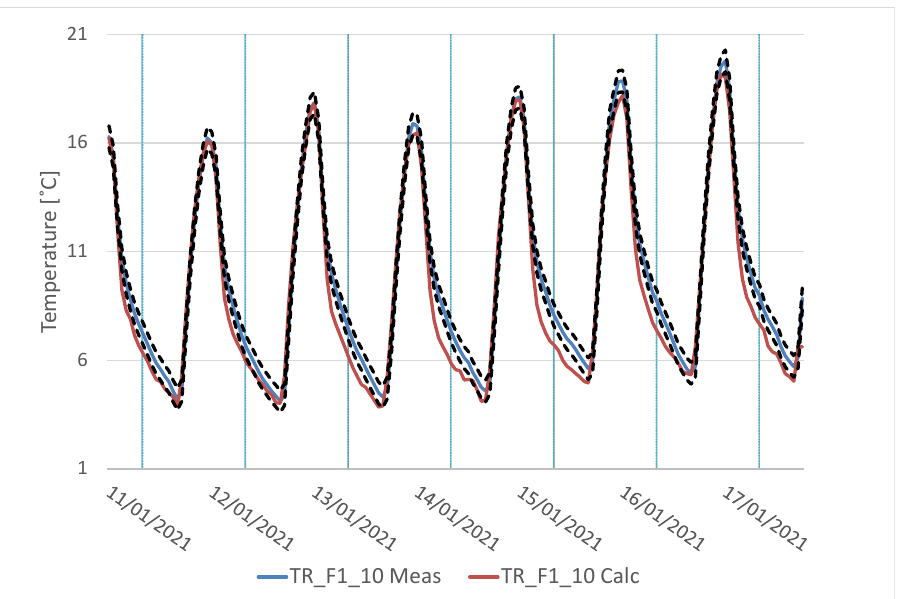
Figure 21. Cell 1. Winter. Grid open. Temperatures of the exterior face of the inner wall in Zone 4: measured ( ) and calculated ( ). Bands of ± 0.5 ◦ C, ( ), are shown.